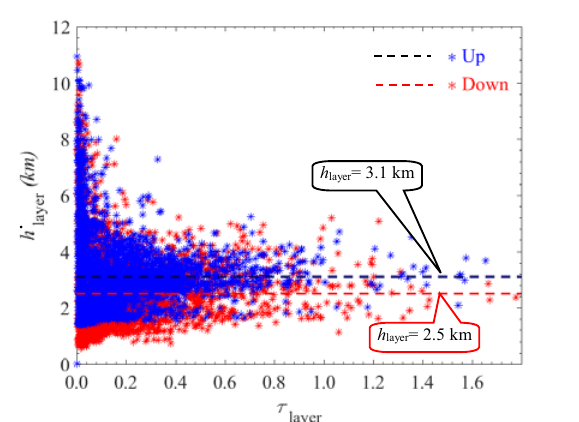
Figure 4 Variations of h layer (cid:14)(cid:10)(cid:16)(cid:13)(cid:17)(cid:18)(cid:6)(cid:18)(cid:10)!(cid:9)(cid:2)"(cid:13)(cid:17)(cid:14)(cid:10)#(cid:16)(cid:13)(cid:17)(cid:10)$%(cid:10) and Down segments. Black (red) dashed lines corresponds to average height of the aerosol layers with ! layer (cid:25)(cid:10)(cid:21)(cid:26)(cid:27)(cid:10)&#(cid:17)(cid:10) Up (Down)